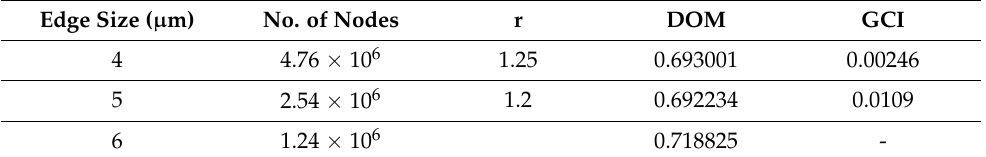
Table 2. Summary of GCI analysis.